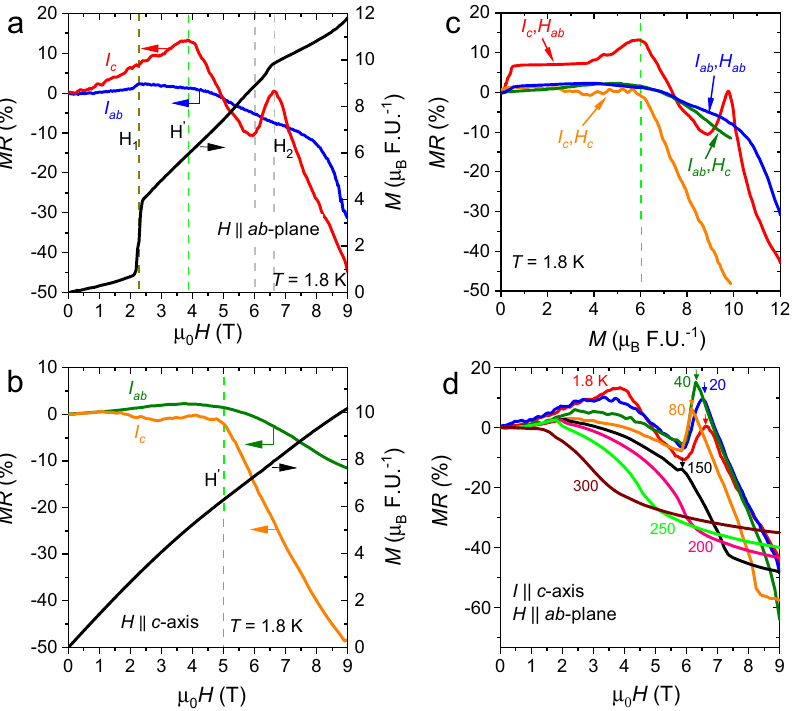
Fig. 2 Magnetoresistance, and magnetization of YMn 6 Sn 6 . a , b Magnetoresistance (MR) at 1.8 K for current along the c -axis, I c , and in the ab -plane, I ab , and the magnetization, M , as a function of magnetic fi eld, H . H is applied in the ab -plane in panel ( a ), and along the c -axis in panel ( b ). Dark gray dashed lines indicate transitions from the distorted spiral to transverse conical spiral phase ( H 1 ) and light gray dashed lines indicate the transition from transverse conical spiral to fan-like phase ( H 2 ). Green dashed lines corresponds to the MR turnover ( H 0 ). c MR as a function of M at 1.8 K. The symbols H c , and H ab refer to the magnetic fi eld applied along the c -axis and in the ab -plane, respectively. Green dashed line shows the MR turnover at H 0 occurs at 6 μ B F.U. − 1 independent of applied fi eld direction. Demagnetization considerations are discussed in Supplementary Note 1. d MR for I c and H ab at the indicated temperatures. The arrows track the MR peak at H 2